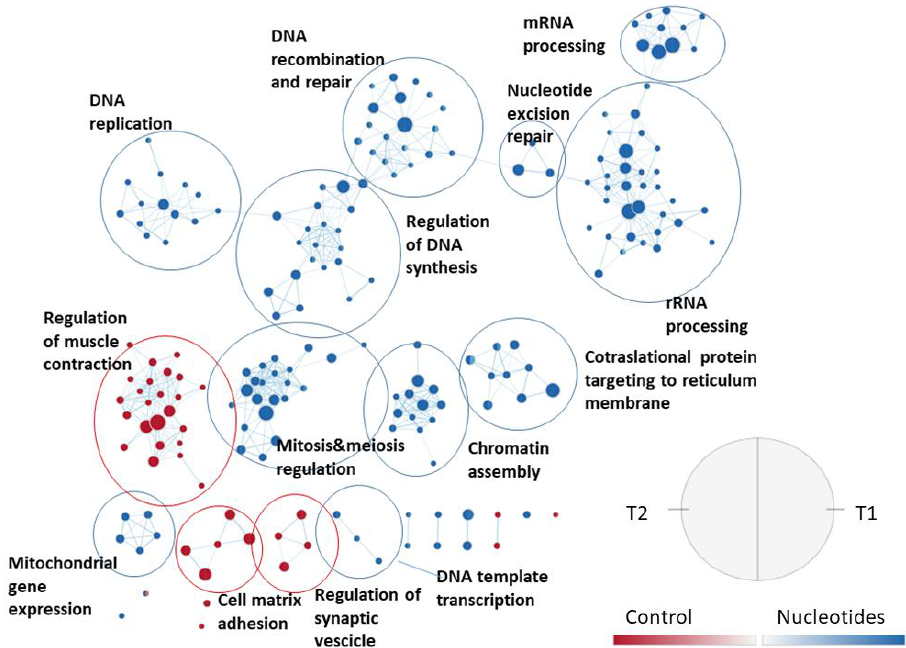
Figure 5. Effect of the diet on jejunal Peyer’s patches gene sets enriched in the two sampling times, using the collection of biological processes according to Gene Ontology. The nodes represent the enriched gene sets in the CO group (red) and NU group (blue). For each node, the right semicircle represents T1 and the left semicircle represents T2. The node size represents the number of genes in each gene set. The threshold for node insertion was a FDR q-value < 0.001. The nodes were joined if the overlap coefficient was ≥ 0.5.